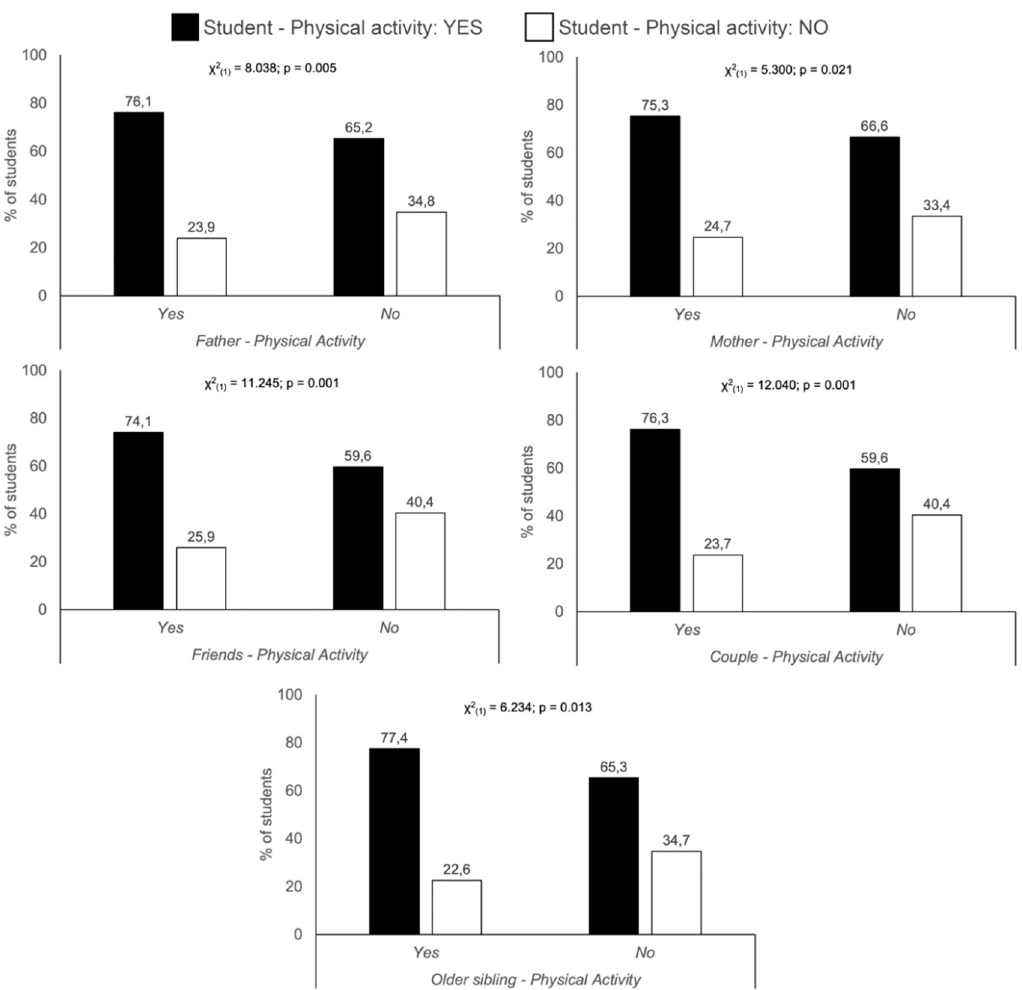
Figure 2. Relation between the students’ performance of physical activity and that of relatives.